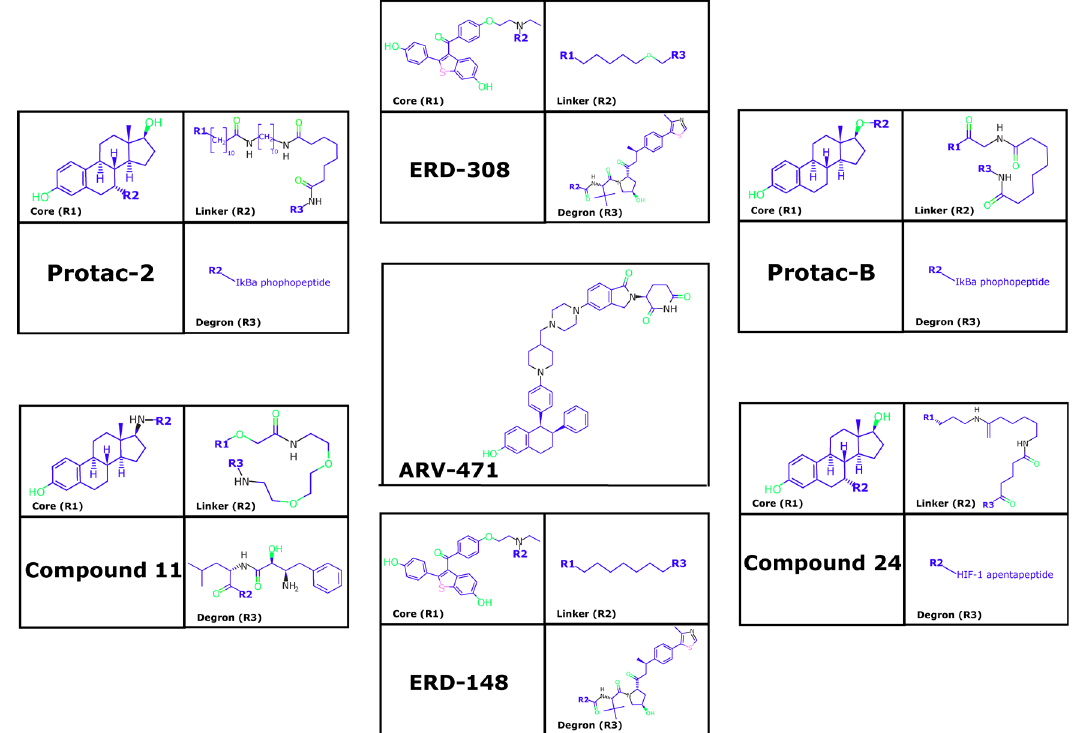
Figure 3. Representative PROTACs for